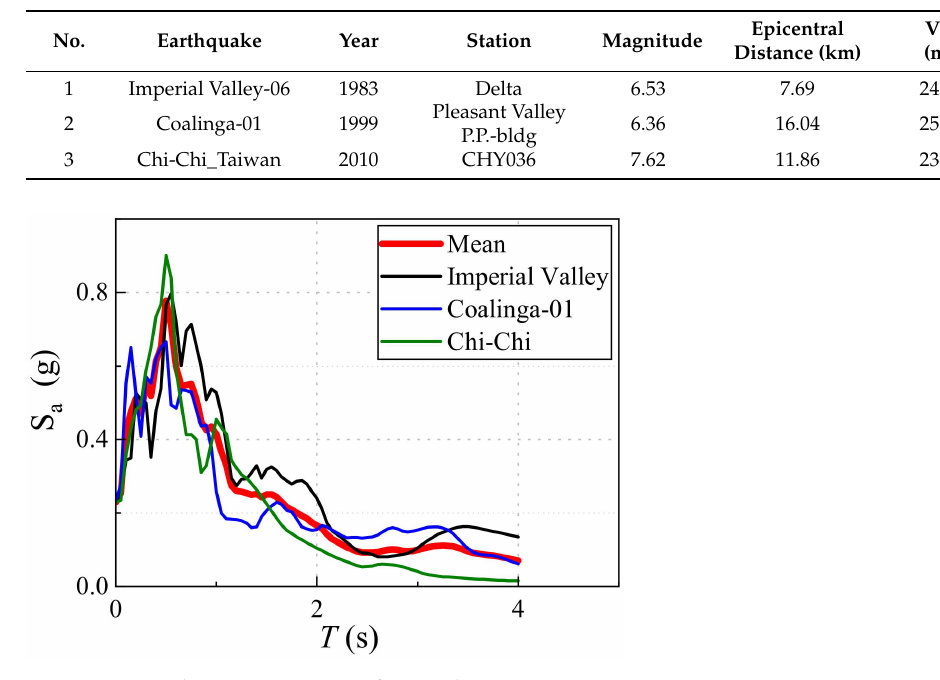
Figure 16. Acceleration spectrum of ground